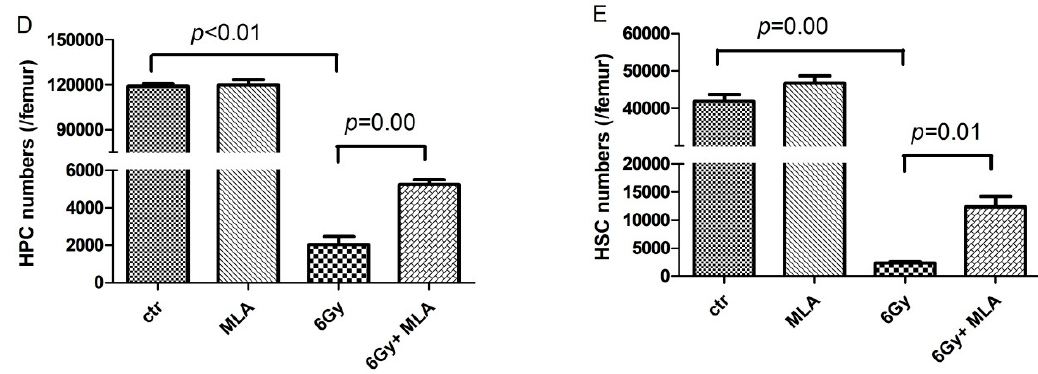
Figure 3. The effects of MLA on the numbers of BMMBNCs, HPCs, and HSCs. ( A ) Number of WBCs; ( B ) number of BMMNCs; ( C ) a representative flow cytometry graph: The BMMNCs were firstly gated by Strepevidin–Percp and C-kit-APC, and the HPC (lin − c-kit + Sca-1 − ,R2) and HSC (lin − c-kit + Sca-1 + ,R3) cells were then analyzed in the lineage negative cells (Strepevidin − , R1); ( D ) number of HPCs; E) number of HSCs. Before the mice were exposed to 6 Gy TBI, they were treated with either vehicle or MLA (10 mg/kg) each day three times. Sham-irradiated control mice and MLA-treated mice were also included. WBCs and BMMNCs were collected and counted after the mice were euthanized nine days after exposure to 6 Gy TBI. The numbers of HPCs ( D ) and HSCs ( E ) were calculated using the following formula: BMMNCs per femur multiply the HPC or HSC ratio detected by flow cytometry. Data are expressed as the mean ± SEM ( n = 5 for each group). The p value shows the difference compared with the IR group.